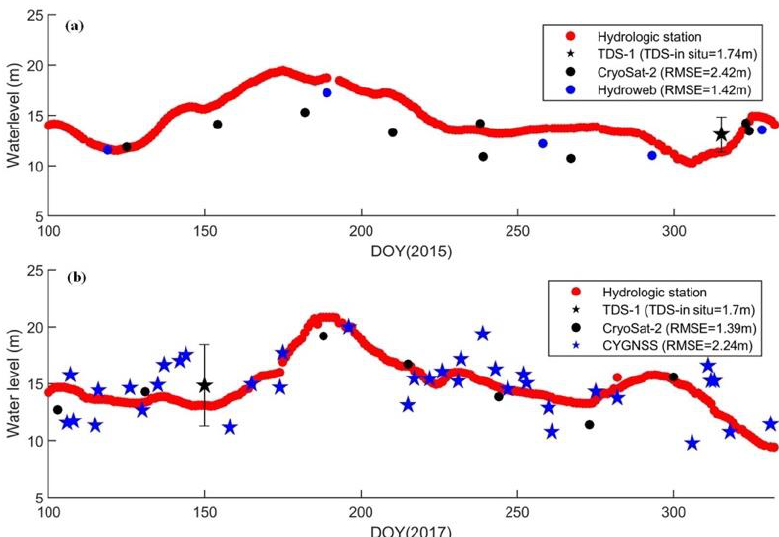
Figure 5. Water level changes of the Poyang Lake observed by ( a ) TDS-1, CryoSat-2, Hydroweb, and the hydrologic station in 2015, and ( b ) TDS-1, CryoSat-2, and the hydrologic station in 2017. First, the miscorrected effects in the raw GPS data. The magnitudes of orbit error from GPS and receivers are reported as 1 m and 2.6 m [24]. Atmospheric effects (e.g., ionospheric effect, tropospheric effect) can result in an error as high as 20 m, which is double the error in one-way GNSS links [26]. The spatial variability of the above-mentioned effects on the extent of each lake is a matter of centimeters [27]. Second, poor precision of the TDS-1 L1b data. The L1b data have limited delay resolution (224.3942 ns), limited receiver bandwidth (~2 MHz), and low peak antenna gain (13.3 dB). The mean observed SNR of the reflected signal over lake surface is ~7 dB, which corresponds to a tracking noise of ∼ 10 m standard deviation [24]. Previous studies have suggested that an ideal GNSS-R configuration for altimetry would require high-gain antennas, wideband ranging codes, and a dual- frequency signal tracking strategy, so that the achievable height precision for a 1 s GNSS-R measurement would be in the order of 1 m [28]. Also, the data have noise that affects the DDM waveforms. These issues could lead to an overall error between 3.5 m and 7 m [29]. Better results can be obtained with larger directivity antennas and less noisy receivers [30]. To guarantee sufficient data samples, we filter the data using thresholds which are relatively lower than the SNR (5 dB), the antenna gain (5 dBi) and the elevation angle (30°). These thresholds are not optimal since the SGR- ReSI is not designed for altimetry measurements. Third, effects from sampling and co-location tolerance. As shown in Figure 4, for large lakes, it is not accurate to use one single value to represent the overall water level without considering the spatial variations. In addition, although the reference of WGS84 ellipsoid is converted to geoid in order to minimize the co-location tolerance, it is not absolutely accurate. The assumed time window tolerance (e.g., the entire summer months) could also lead to the altimetry dispersion, particularly in large lakes. Finally, uncertainties from the retrieval algorithm. The altimetry precision obtained using the HALF method cannot represent the truly achievable precision [31], since the tracking HALF point only takes the information near the specular point. One 0.25 chip delay increment could correspond to a height increment of 37 – 50 m [3]. This study uses the same method as that for retrieving sea surface height in [3]. Although the waveform of lake better maintains the specular characteristics than that over sea surface, the accuracy of water level estimates should be affected by the water-land interactions, particularly for lakes that are not large enough. Several theoretical studies predicted that per-second altimetry precision can range from 0.2 to 3 m depending on GNSS-R mission configurations and processing algorithms [23,29,31].